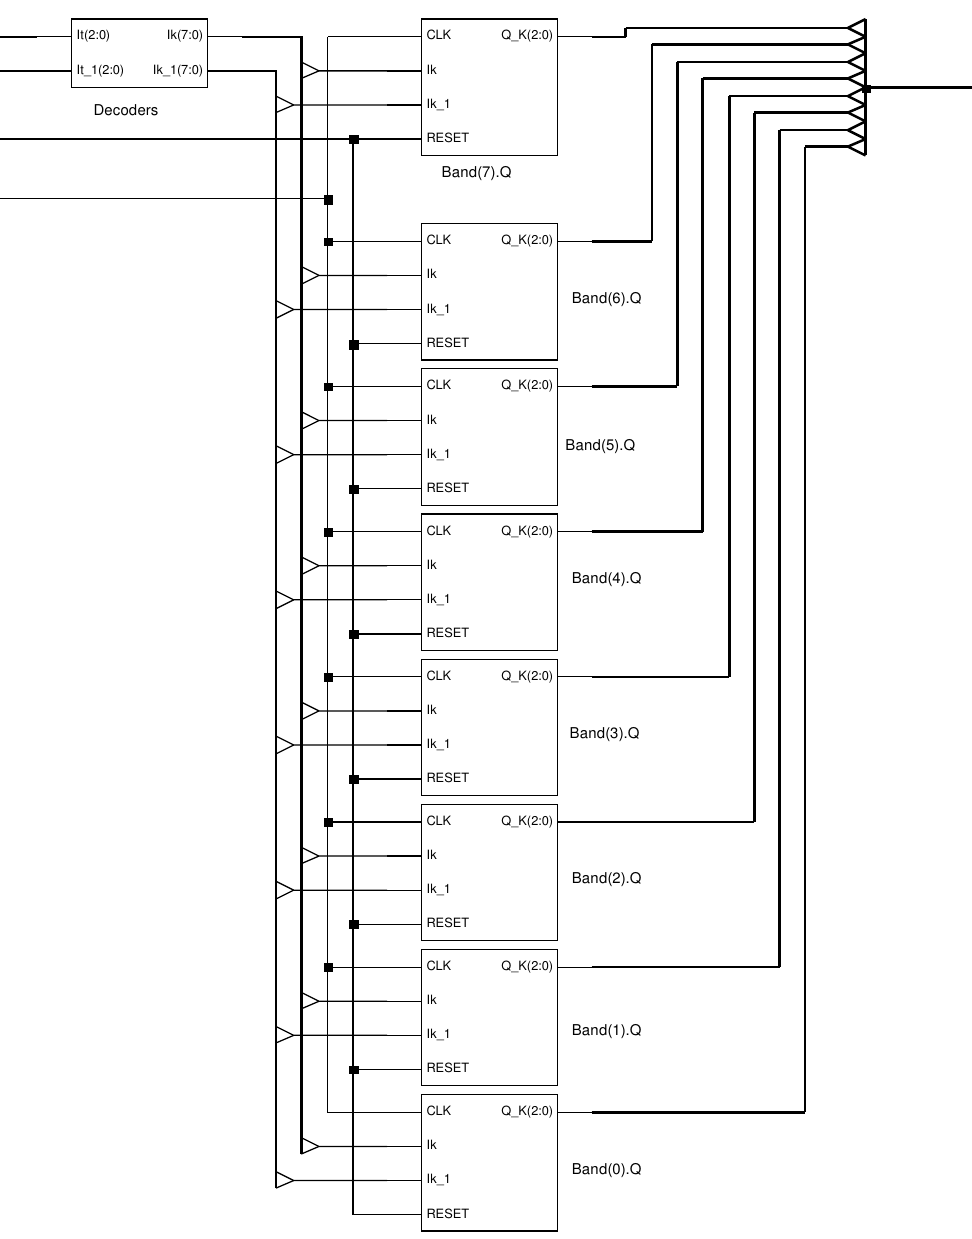
Figure 3. Layout of a motion-detection AC